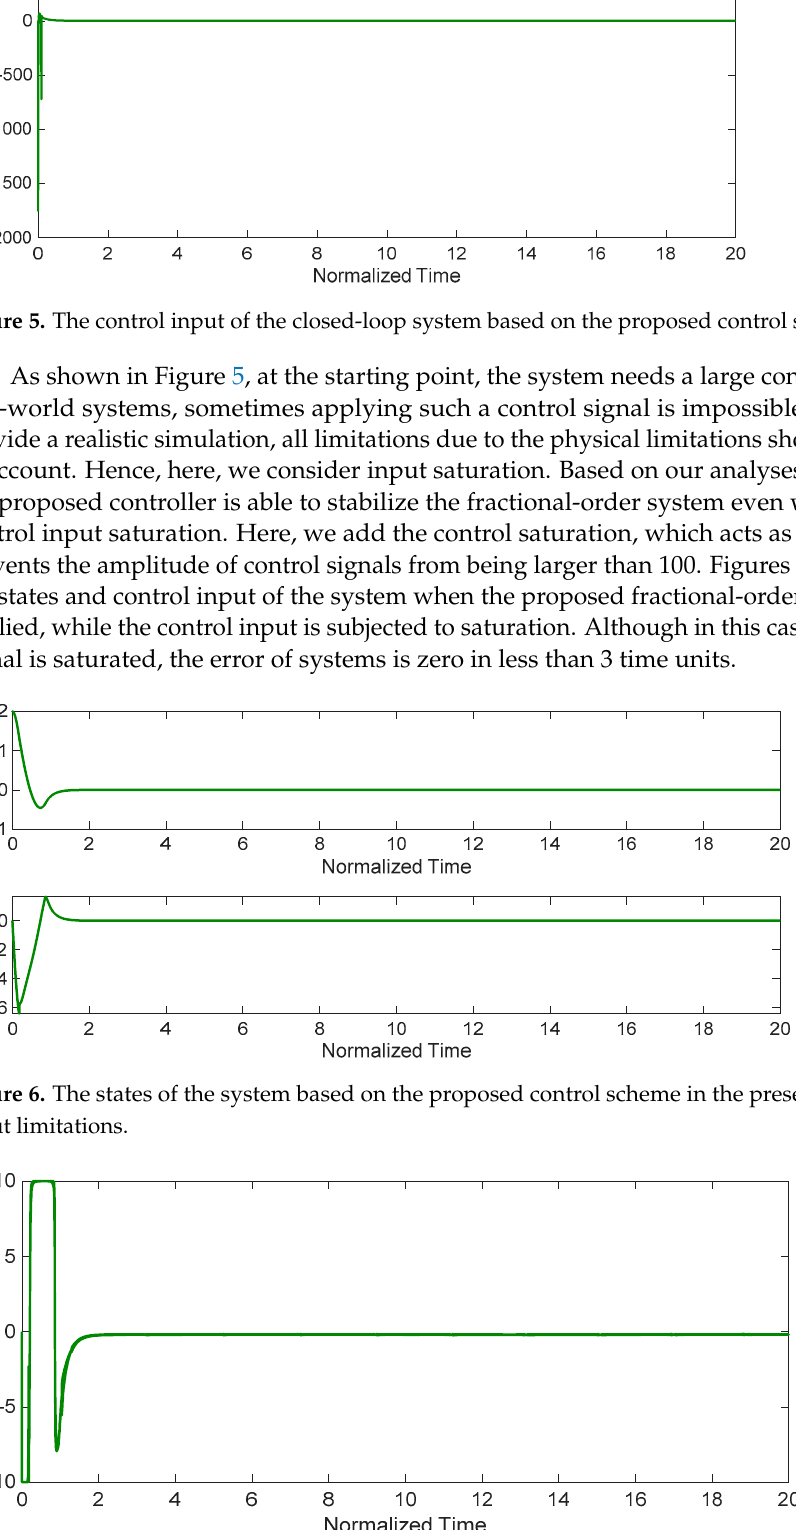
Figure 4. The states of the system based on the proposed control scheme.